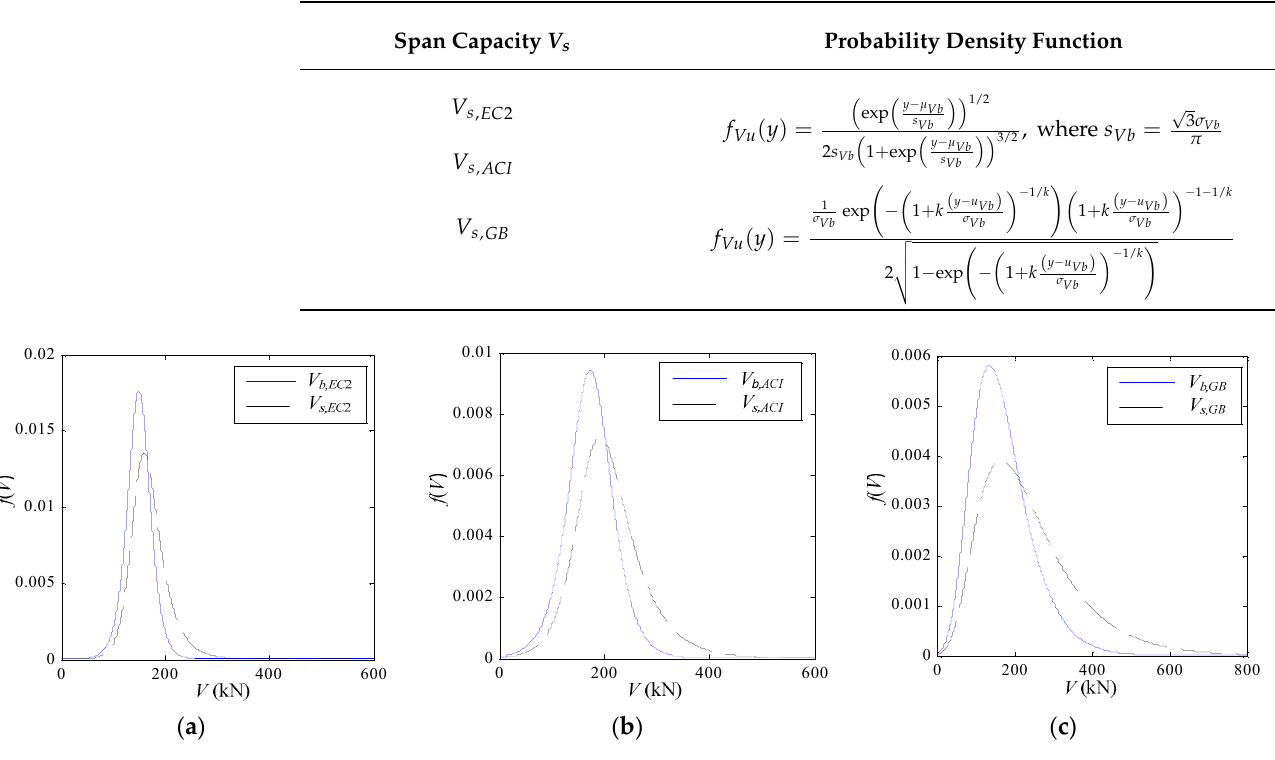
Table 6. Probability density functions for the shear span’s shear strength V u .